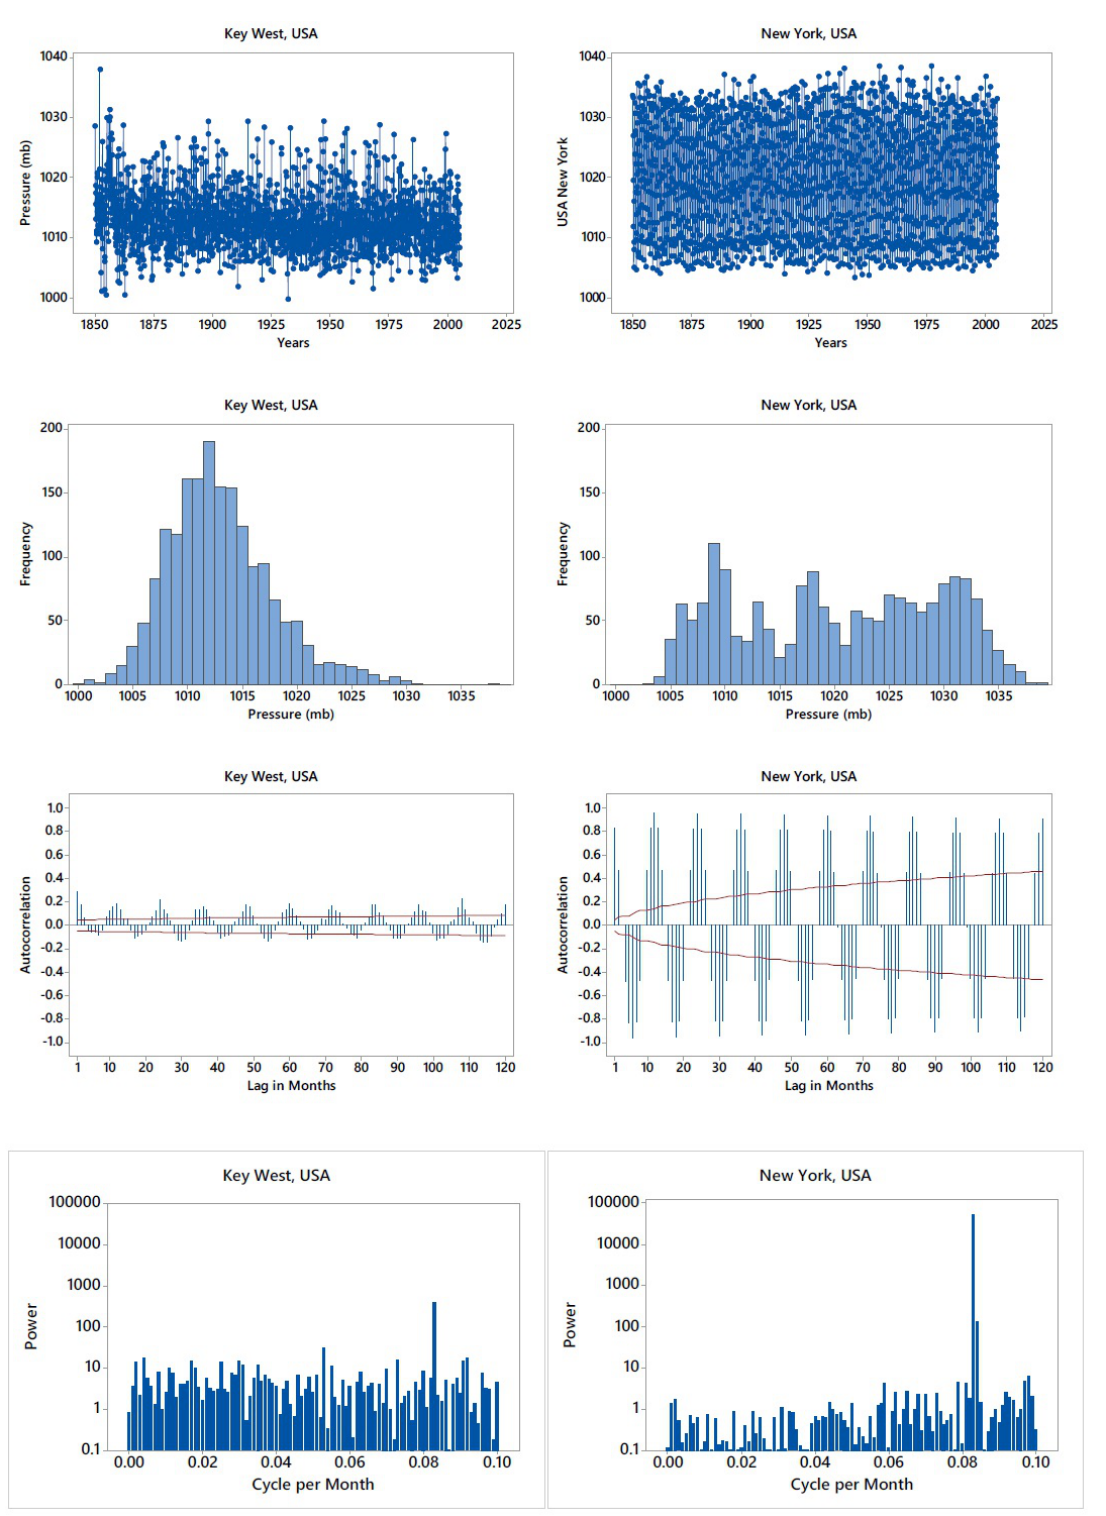
Figure 3: Atmospheric Pressure time series at Key West, USA and New York, USA tide gauge